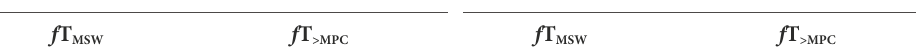
TABLE 6 Pharmacodynamic parameters f T MSW and f T >MPC based on MIC and MPC of amikacin in epithelial lining fluid against five Acinetobacter baumannii isolates harboring OXA-23 and other serine- β -lactamases. Double-combination of amikacin with polymyxin-B